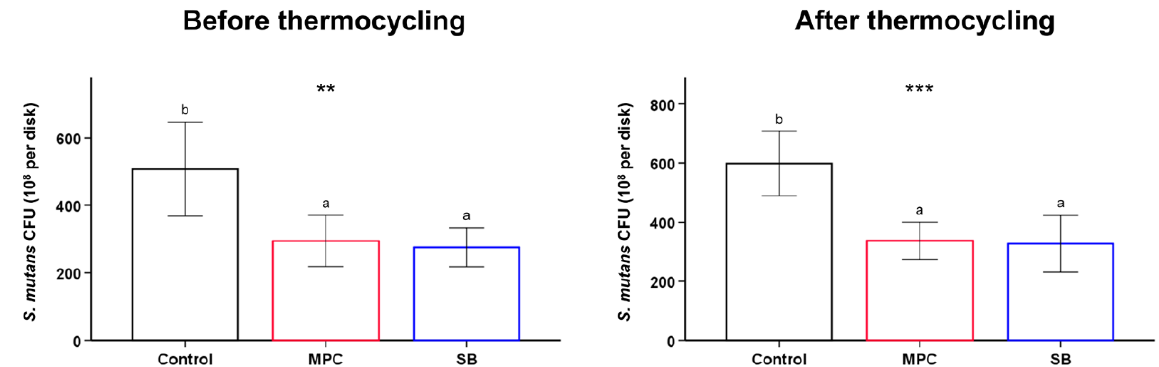
Figure 4. Colony forming unit (CFU) counts of S. mutans attached to poly(methyl methacralyate) (PMMA) (Control) and PMMA incorporated with 2-methacryloyloxyethyl phosphorylcholine (MPC) or sulfobetaine methacrylate (SB), before and after thermocycling. Different lowercase letters above the bars indicate significant differences by post-hoc Tukey’s test. *** p < 0.001, ** p < 0.01 for comparisons between PMMA with and without the zwitterion analyzed by one-way analysis of variance (ANOVA).